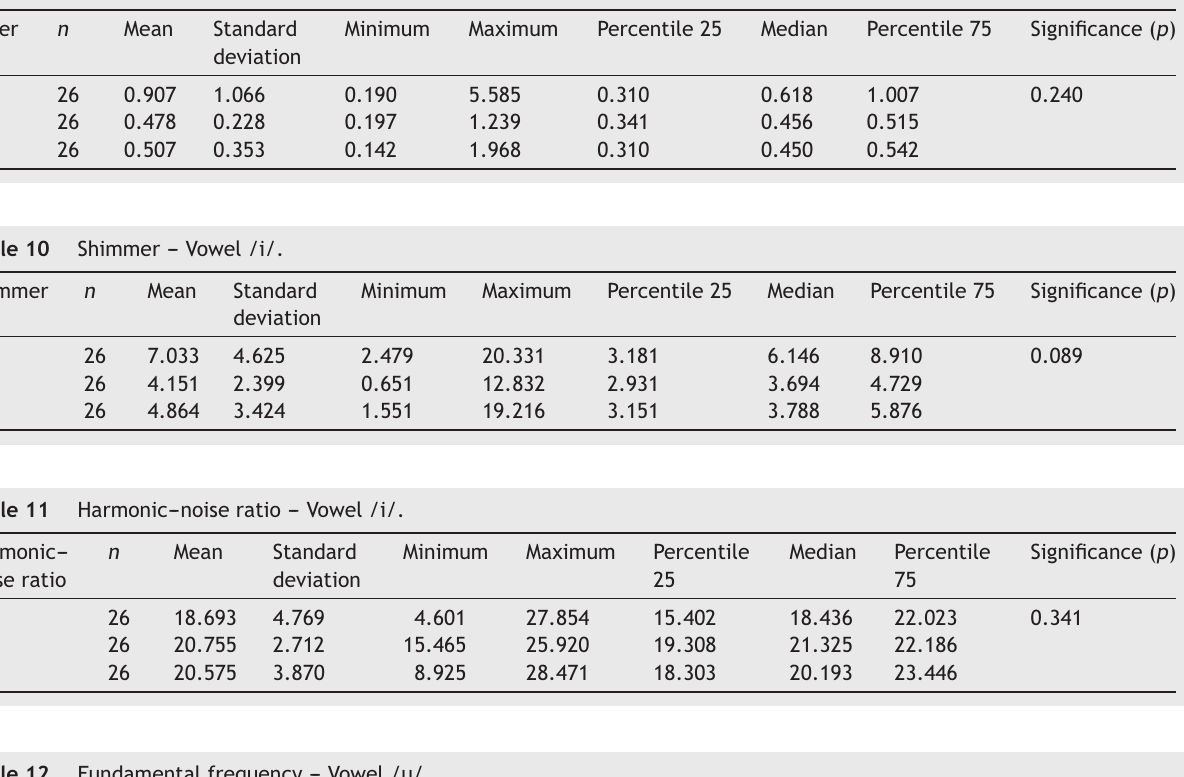
Jiitter --- Vowel /i/.